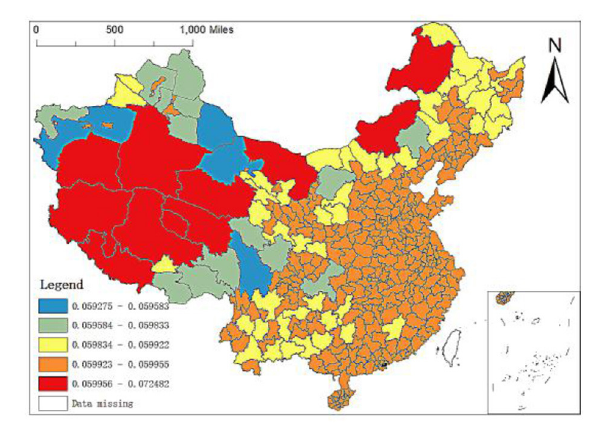
FIGURE 6 | Spatial distribution of regression coefficients of altitude.